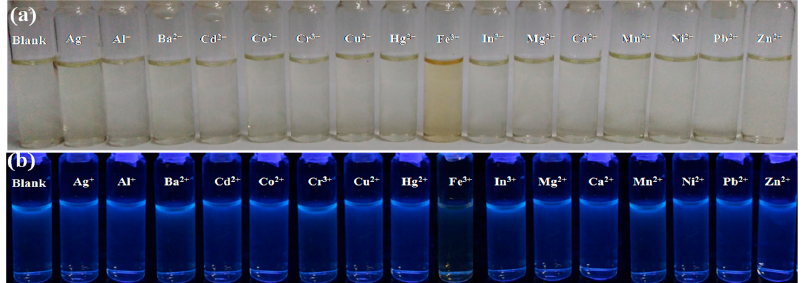
Figure 1. ( a ) Color of receptor 1 with different metal ions, ( b ) fluorescence of receptor 1 under UV irradiation ( λ ex = 365 nm) in the presence of various metal ions.